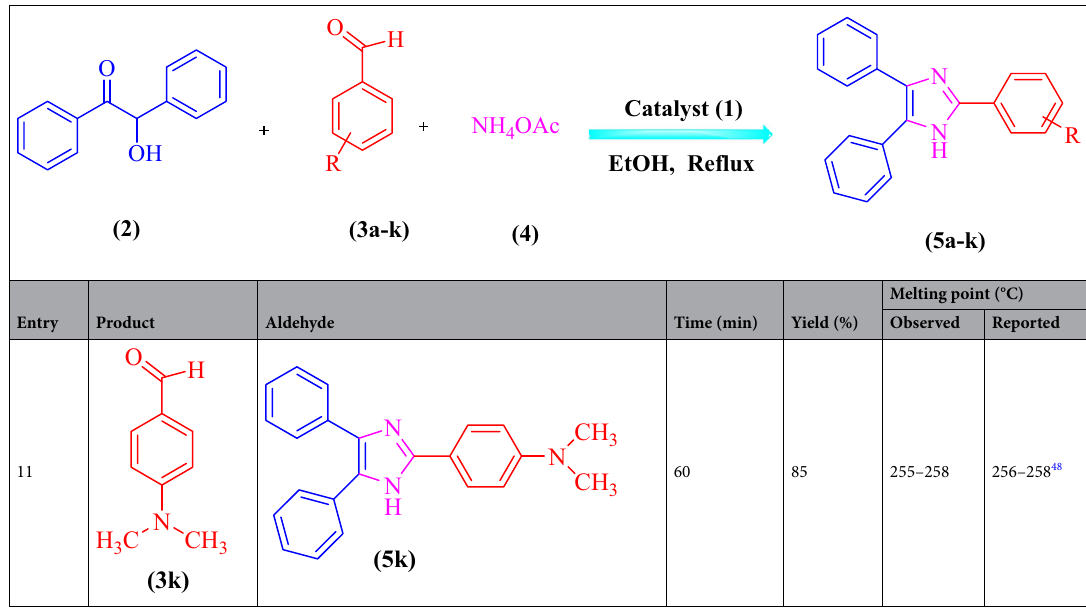
Table 2. Synthesis of imidazole derivatives 5a – k from three-component condensation of benzoin ( 2 ), aldehyde derivatives 3a – k , and ammonium acetate ( 4 ) in the presence of LDH–APS–PEI–DTPA nanocomposite ( 1 ). Reaction conditions: Benzoin ( 2 , 1 mmol), benzaldehyde ( 3a – k , 1 mmol), and ammonium acetate ( 4 , 2.5 mmol) in the presence of 5 mg LDH–APS–PEI–DTPA nanocomposite ( 1 ) in EtOH under reflux